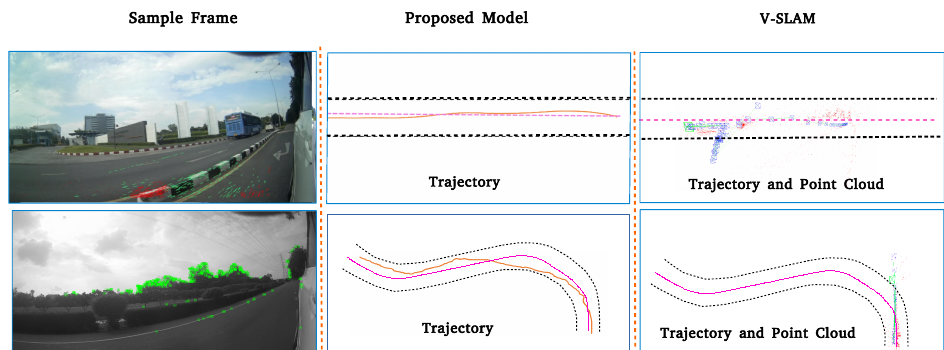
Figure 10. Experiment V (comparison between proposed method and visual SLAM) results. Row 1 shows results for a long straight road. Black dotted lines indicate the border of the road. Pink dotted lines indicate the ground truth center of the road. Orange lines indicate estimated trajectories of the host vehicle. ORB-SLAM was not able to detect features in frames 2790-3245. When ORB-SLAM relocalizes the vehicle, it estimates an incorrect trajectory for the host vehicle. The proposed model, on the other hand, is able to maintain a much more accurate trajectory. Row 2 shows results for a winding road. In this condition, ORB-SLAM works for only a short period of time. After that, it falls and cannot relocalize. The proposed model maintains a smooth trajectory until the host vehicle parks. We conclude that the proposed model for trajectory estimation of the host vehicle is better than ORB-SLAM in outdoor road